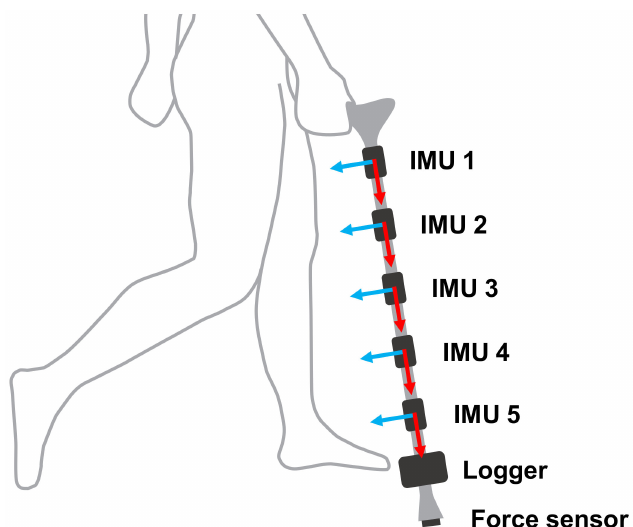
Figure 4. Diagram of the instrumented cane used in this study. Five inertial measurement units (IMU) are placed at equal intervals throughout the cane, and one data logger receives the signal from the force sensor placed on the tip of the